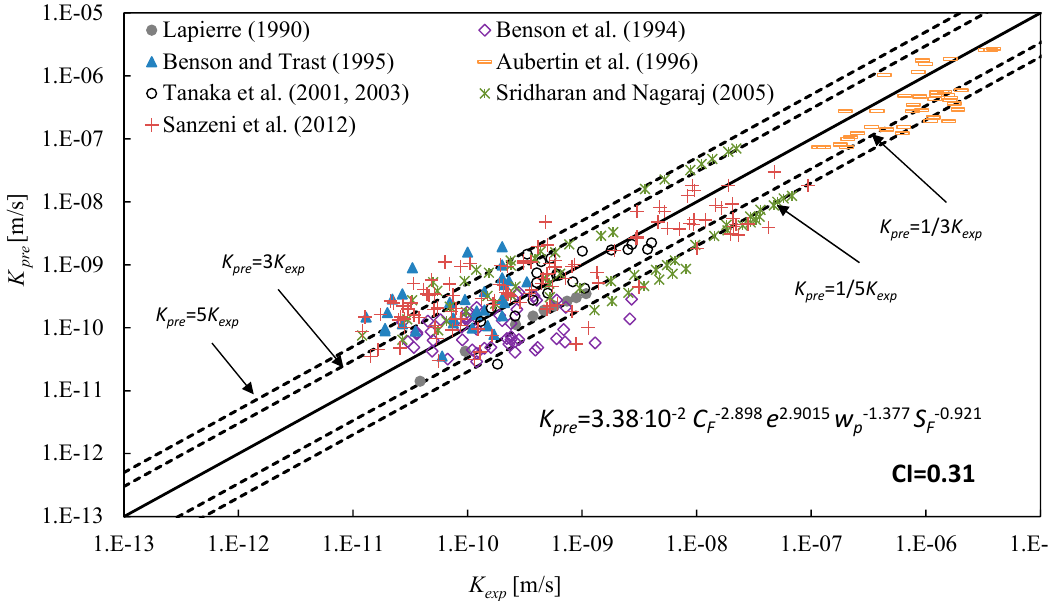
Figure 3. Experimental ( K exp ) and predicted value ( K pre ) of the saturated hydraulic conductivity as determined by Equation (20).